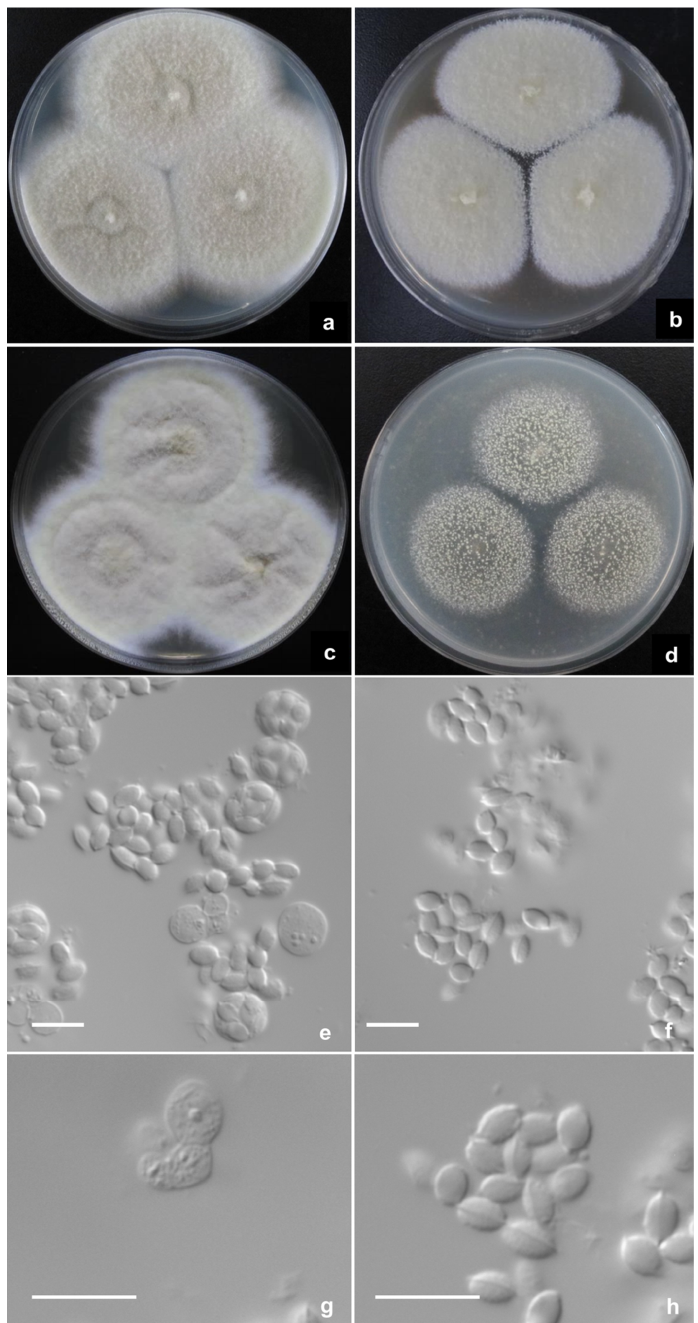
Figure 4. Talaromyces zhenhaiensis AS3.16102 T incubated at 25 °C for 7 days. Colonies on ( a ) CYA. ( b ) MEA. ( c ) YES. ( d ) OA. ( e , g ) Asci and ascospores. ( f , h ) Ascospores. Scale Bars: 10 µm.